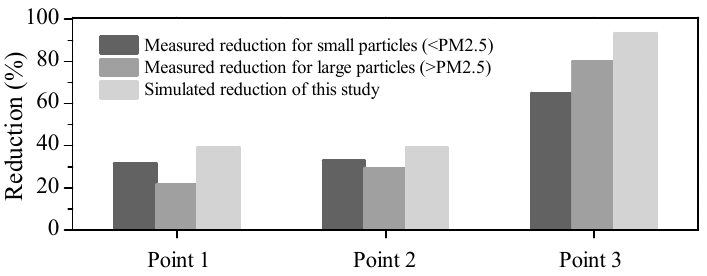
Figure 5. Comparison of simulated and measured reduction rate of particle numbers.